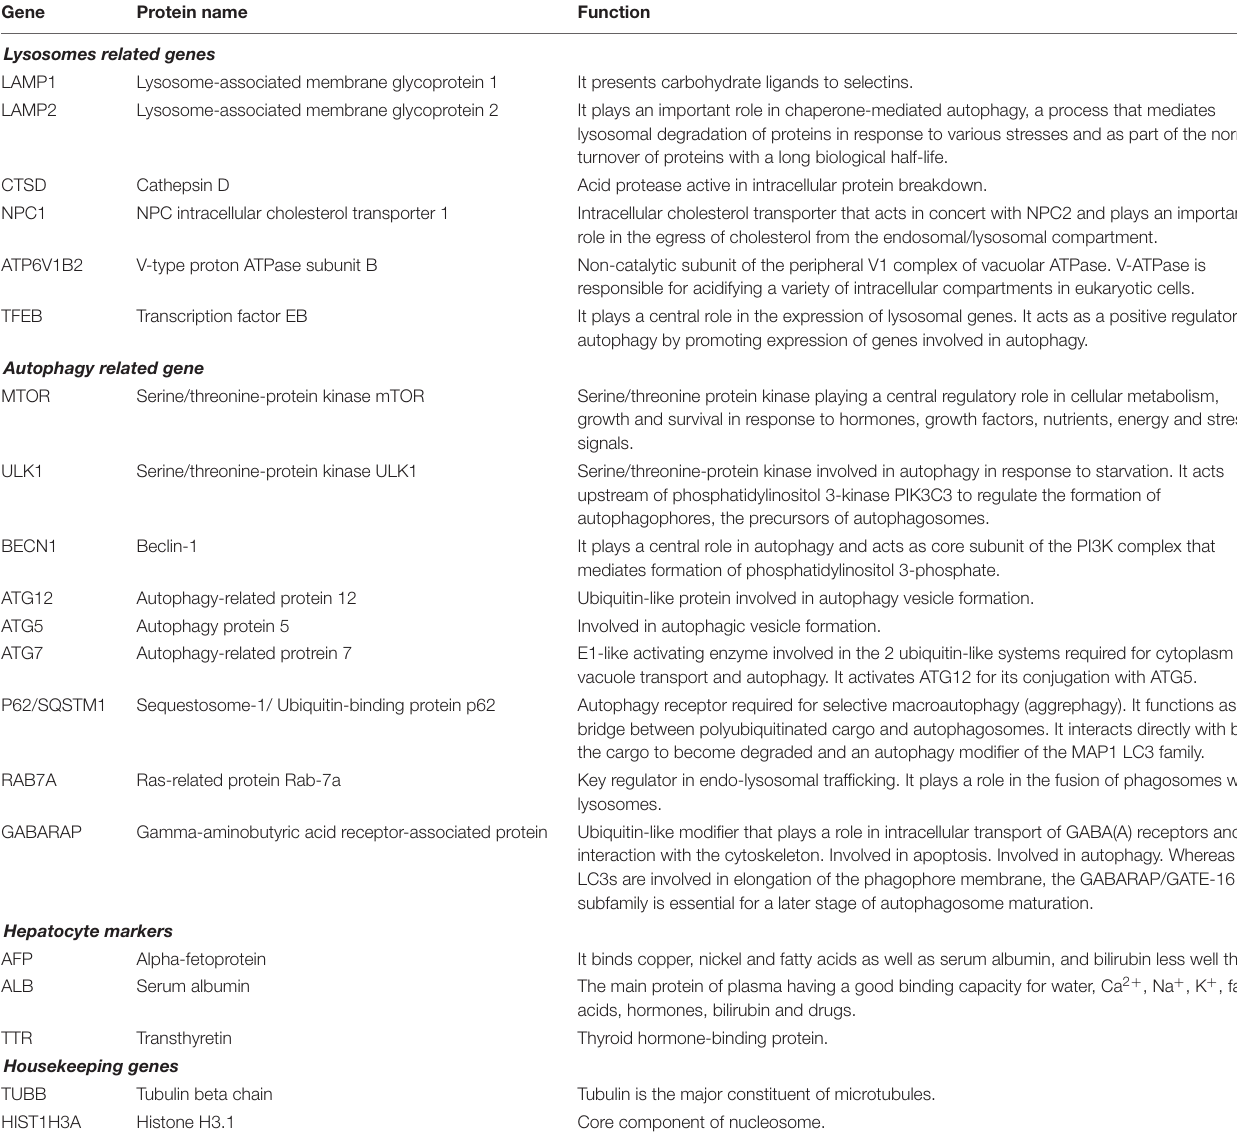
TABLE 2 | Gene, Protein name and Function are derived from https://www.uniprot.org. Gene Protein name